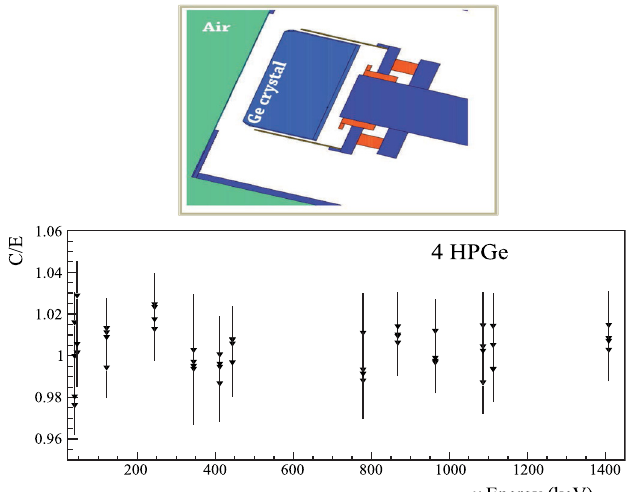
Fig. 2. On the top is represented the adjusted geometry of a HPGe planar crystal obtained during the C/E optimization (bottom) procedure for g -ef fi ciency